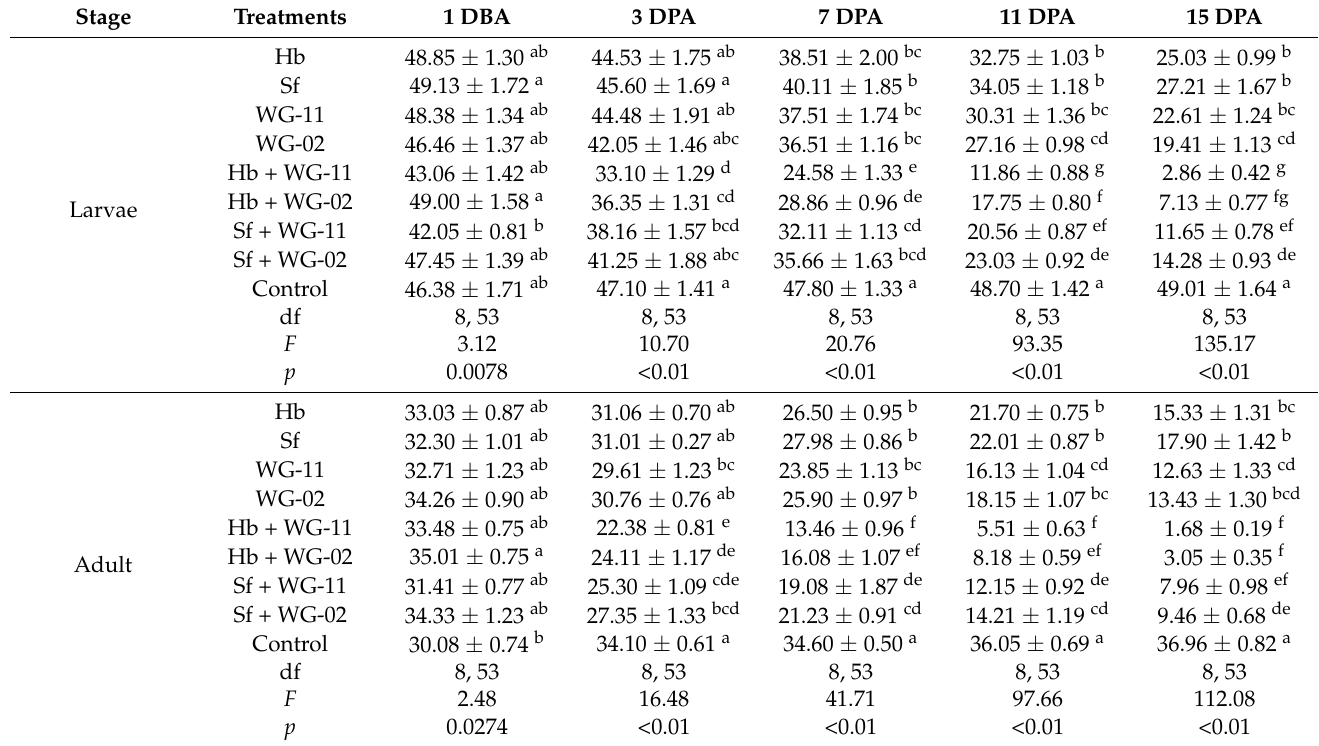
Table 4. Mean ( ± SE) adult emergence of Thrips tabaci at 1 day before application (DBA), and 1, 3, 7, 11, and 15 days post- application (DPA) when treated with Hb = Heterorhabditis bacteriophora , Sf = Steinernema feltiae , WG-11 = Beauveria bassiana (WG-11), WG-22 = Metarhizium anisopliae (WG-02), Hb + WG-11 = H. bacteriophora + B. bassiana , Hb + WG-02 = H.